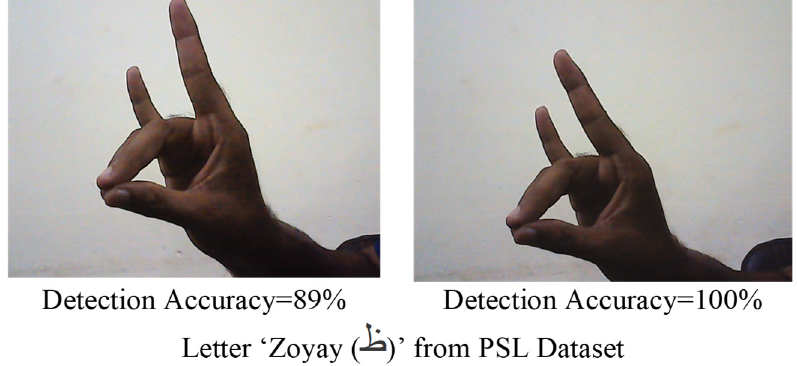
Figure 14. Processing variation in same hand gesture scenario 1.